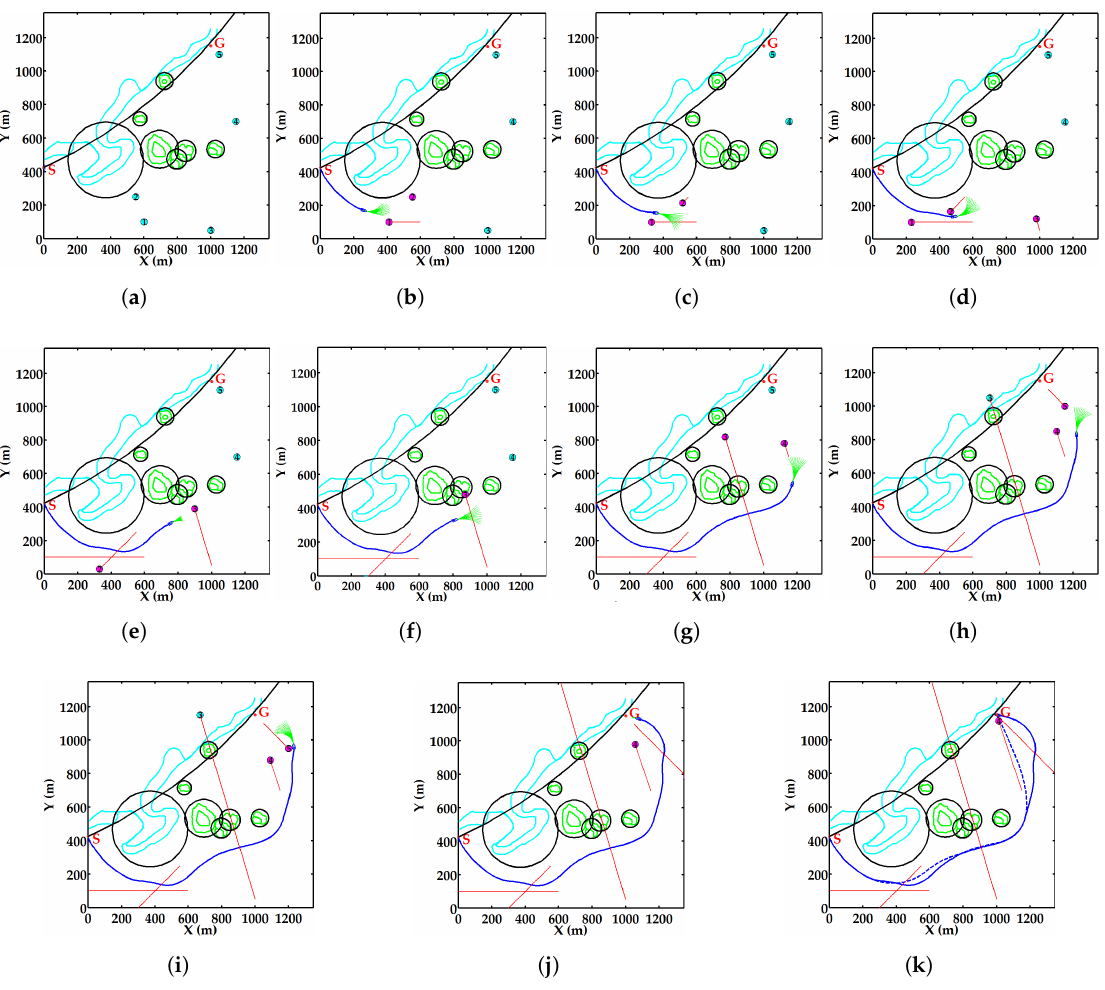
Figure 13. Demonstration diagram of the USV in a dynamic real environment. ( a ) Time 1 s; ( b ) Time 38 s; ( c ) Time 46 s; ( d ) Time 56 s; ( e ) Time 83 s; ( f ) Time 92 s; ( g ) Time 126 s; ( h ) Time 149 s; ( i ) Time 159 s; ( j ) Time 192 s; ( k ) Time 237 s.